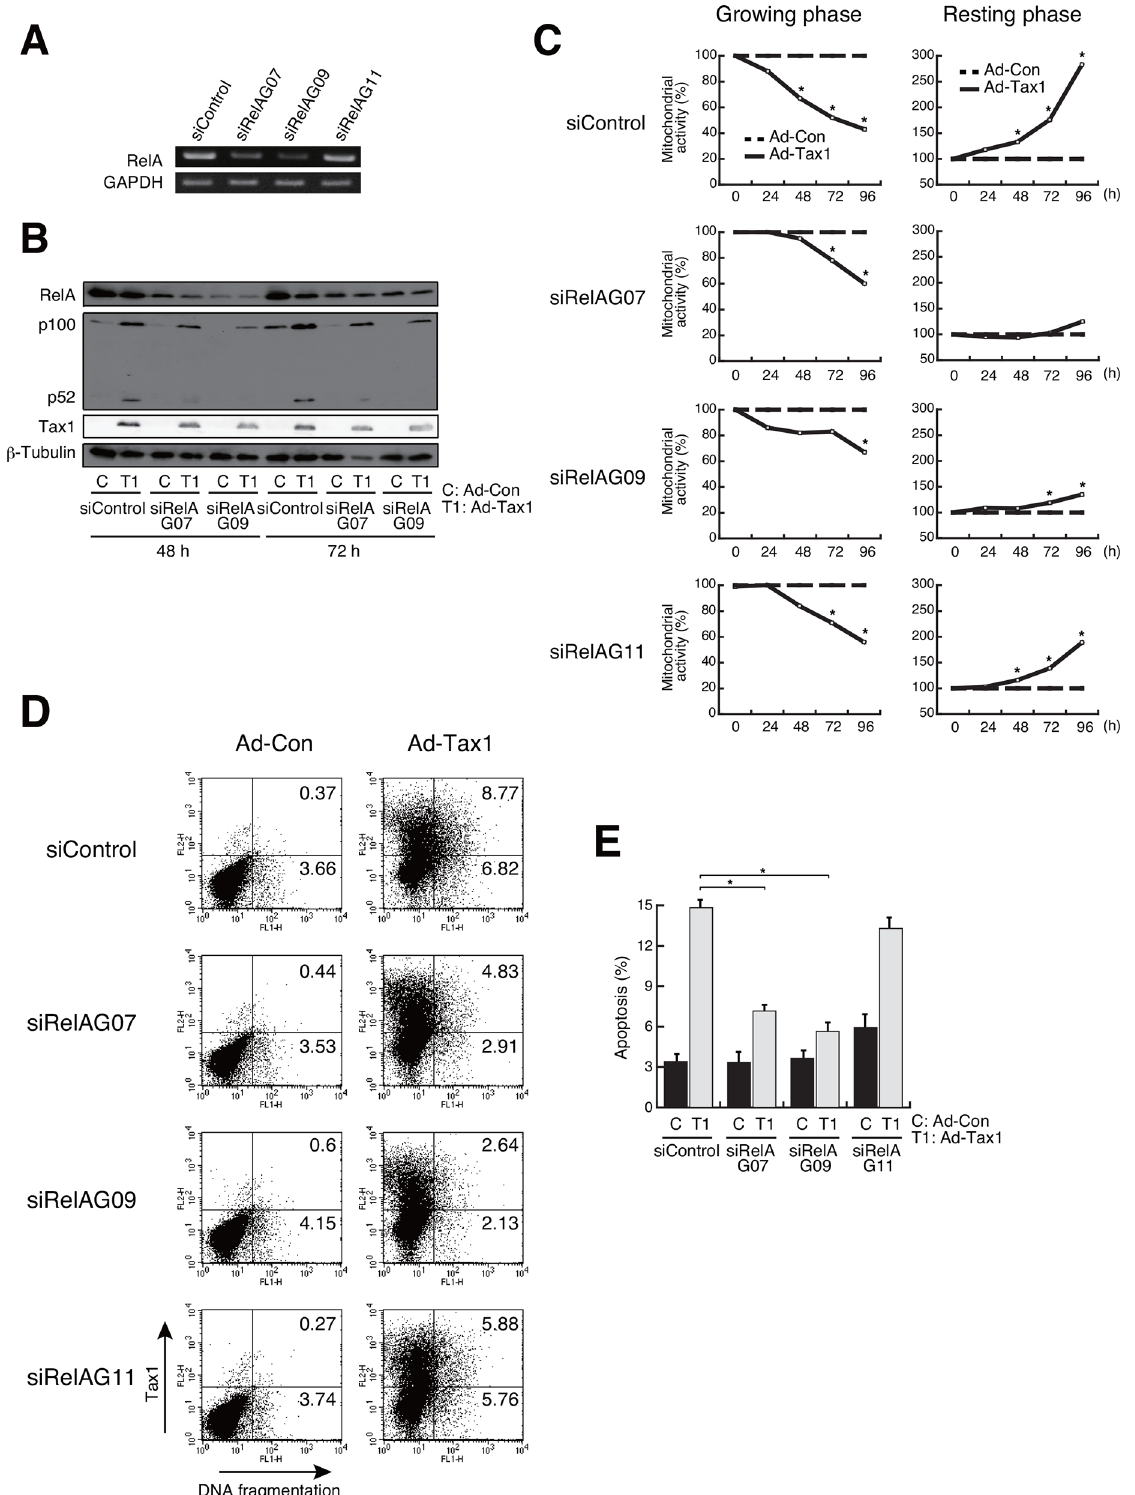
Fig 7. Participation of RelA in Tax1-mediated growth inhibition and apoptosis. (A) Growing Kit 225 cells were transfected with RelA-specific siRNA and cultured for 72 h. RelA expression was examined by RT-PCR. GAPDH was used as an internal control. (B) Growing Kit 225 cells were transfected with RelA- specific siRNA 24 h before adenovirus infection (Ad-Tax1 or Ad-Con), and harvested 48 h and 72 h post infection for western blotting. RelA, p100, p52